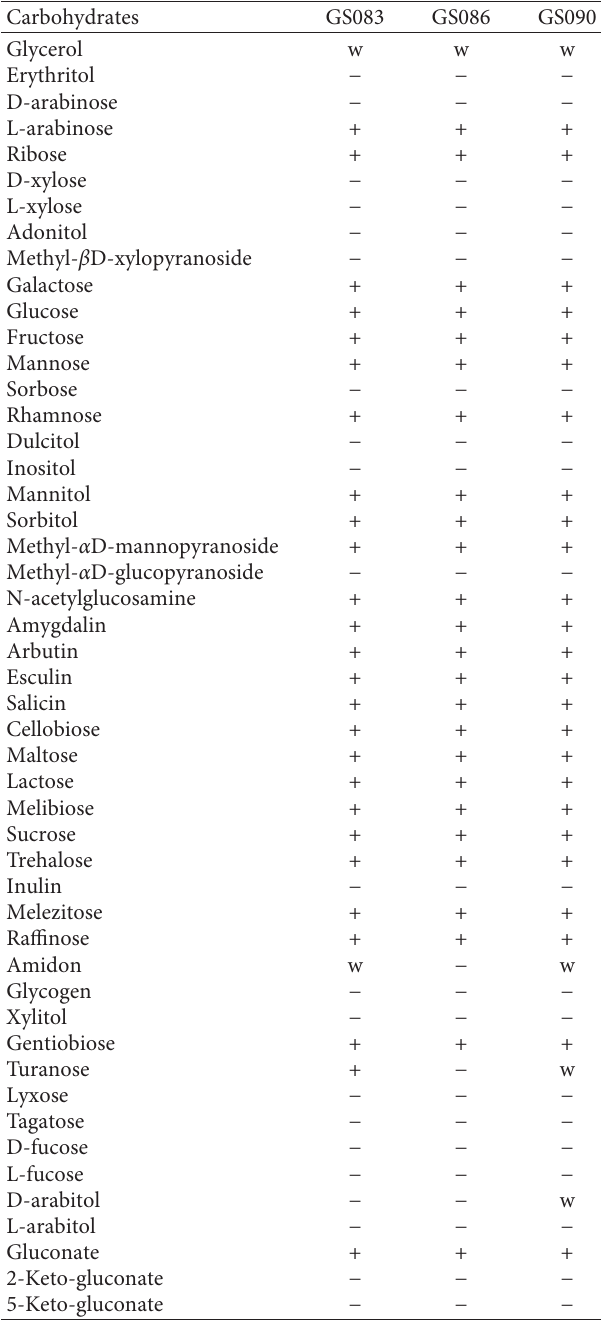
Table 3: Carbohydrate fermentation patterns of L . plantarum GS083, GS086, and